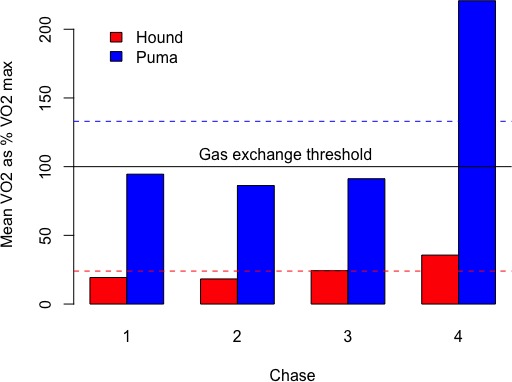
Estimated mean metabolic rate (\documentclass[12pt]{minimal}
\usepackage{amsmath}
\usepackage{wasysym}
\usepackage{amsfonts}
\usepackage{amssymb}
\usepackage{amsbsy}
\usepackage{upgreek}
\usepackage{mathrsfs}
\setlength{\oddsidemargin}{-69pt}
\begin{document}
}{}$\dot {\mathrm{V }}{\mathrm{O}}_{2}$\end{document}V ˙O2, ml O2kg−1min−1) expressed as a percentage of \documentclass[12pt]{minimal}
\usepackage{amsmath}
\usepackage{wasysym}
\usepackage{amsfonts}
\usepackage{amssymb}
\usepackage{amsbsy}
\usepackage{upgreek}
\usepackage{mathrsfs}
\setlength{\oddsidemargin}{-69pt}
\begin{document}
}{}$\dot {\mathrm{V }}{\mathrm{O}}_{2\mathrm{MAX}}$\end{document}V ˙O2MAX for hounds (red) and pumas (blue) during each chase.